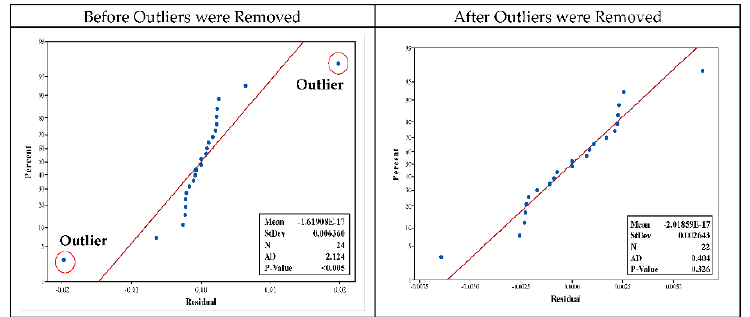
Figure 2. Anderson–Darling normality test for bulk density.